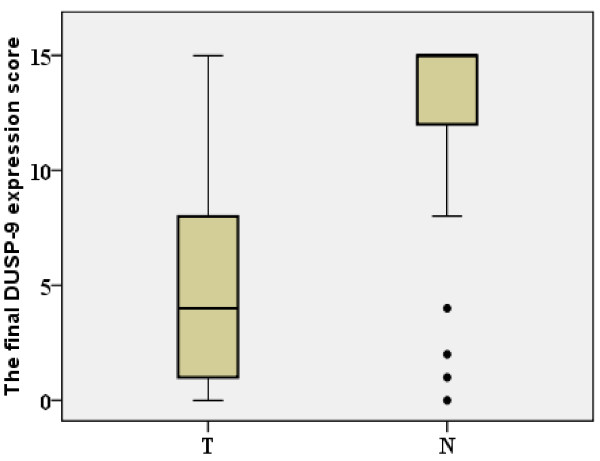
Decreased protein expression of DUSP-9 in ccRCC. The relative protein expression of DUSP-9 in ccRCC tumor (T) tissue samples was lower than that in the paired adjacent normal (N) tissue samples (n = 107, P < 0.001). The bottom and top of the box are the lower and upper quartiles, and the band near the middle of the box is the median. The ends of the whiskers represent the 2.5th percentile and the 97.5th percentile. Four black spots represent the special value outliers.